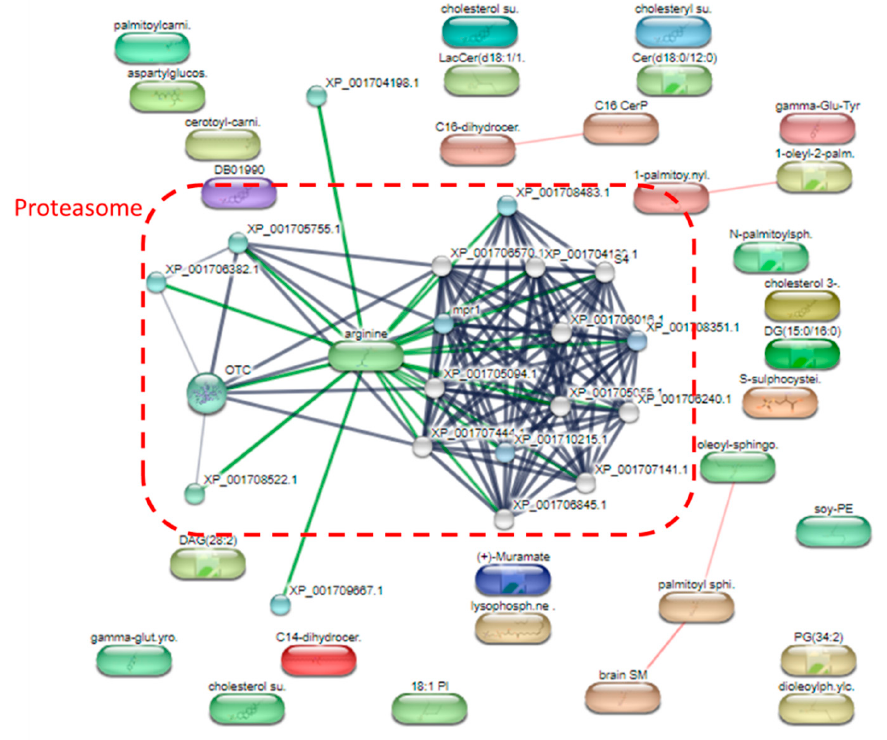
Figure 6. A detailed analysis of the pathways of significantly altered metabolites after metronida- zole exposure.